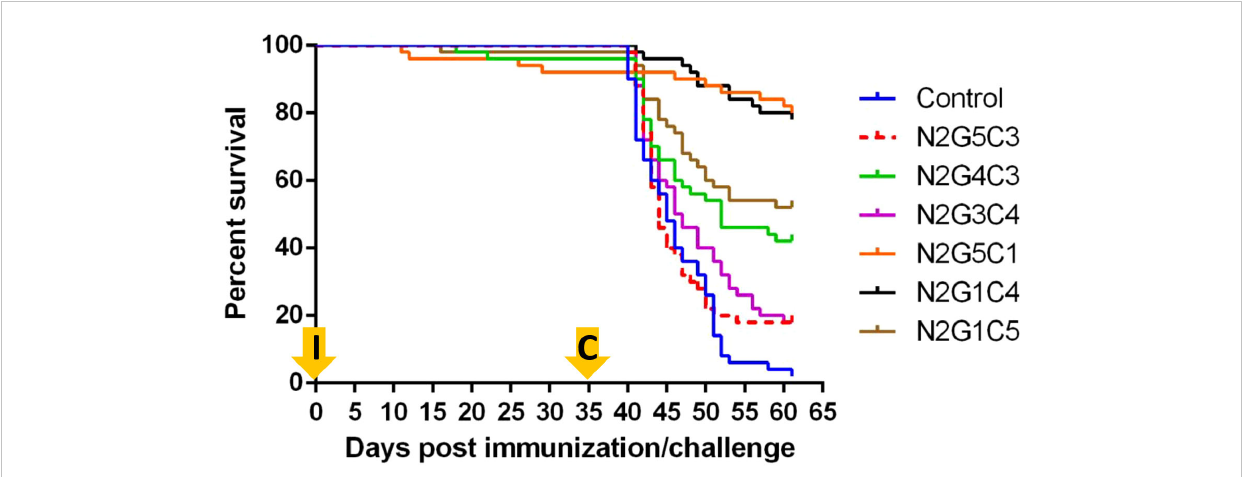
FIGURE 8 Fish survival curves following infection of trout by bath immersion with rVHSV GO -NNV. Fifty virus-free juvenile rainbow trout (mean weight of 0.8 g) were infected with 6 rVHSV GO -NNV as described in materials and methods. Fish mortality rates were recorded every day for 35 days. Then, rVHSV GO -NNV-immunized fi sh were challenged with wtVHSV. Fish mortality rates were recorded every day for 30 additional